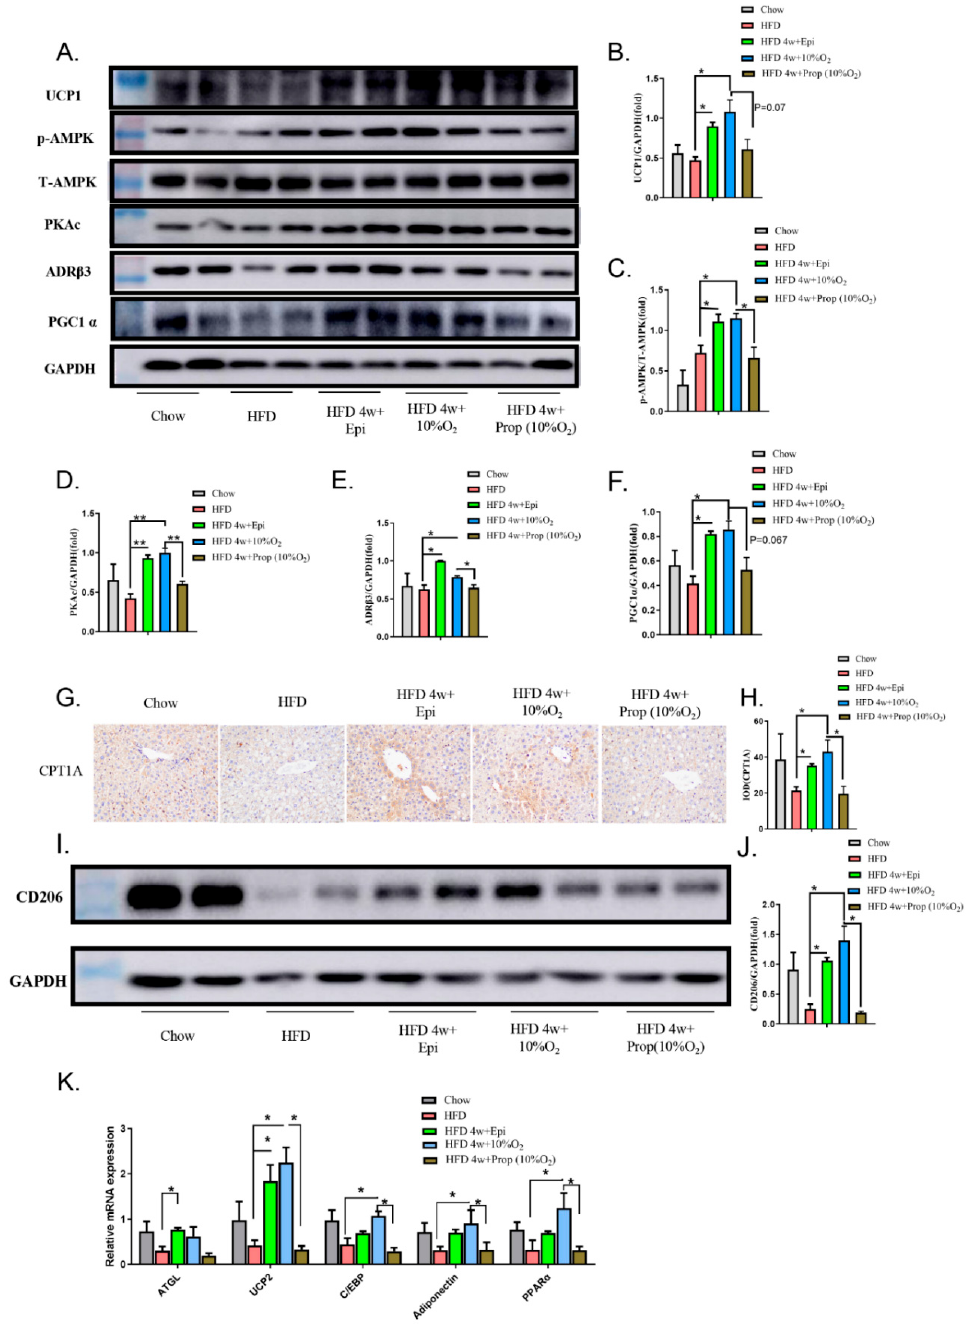
Figure 6. Epinephrine mediates the effect of hypoxia on the expression of modulators for metabolism in liver. ( A ) Liver extracts were blotted with antibodies against UCP1, ADR3, PKAc, P-AMPK, AMPK, and PGC1 α . A representative set of blots from two independent experiments is presented. ( B – F ) The protein bands in ( A ) were quantified using Image J software. ( G , H ) Liver tissues were examined by immunohistochemical staining of CPT1A (40×) and the positive intensity was analyzed by Image J software ( H ). ( I , J ) Western blot analysis of CD206 was performed ( I ) and semi-quantification normalized with GAPDH ( J ). ( K ) qPCR analysis was performed on mRNA for ATGL, UCP2, C/EBP, Adiponectin , and PPAR α using 18S rRNA as an internal control. Student's t -test was used for all statistical analysis (mean ± SEM). * p < 0.05, ** p < 0.01.